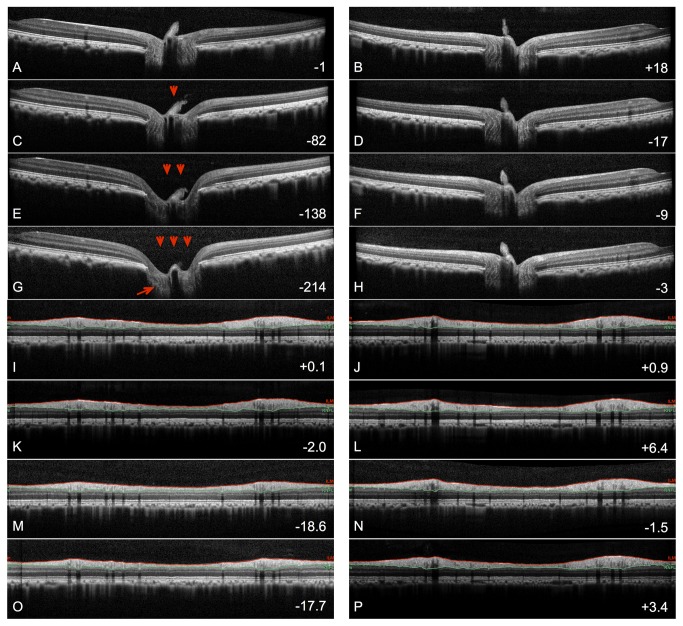
Longitudinal series of SDOCT B-scans crossing through the optic nerve head and fovea in the EG eye (A,C,E,G) and fellow control eye (B,D,F,H) of the same animal shown in Figure 1.The four time points shown are: baseline 3 (A,B), MPD endpoint (C,D), RNFL thickness endpoint (E,F) and the final available time point (G,H). (I-P) SDOCT peripapillary circular B-scans obtained at the same set of four time points. The numbers in the lower right corner of each panel represent the change from baseline average (in µm) for MPD (panels A-H) and RNFL thickness (panels I-P). Signficant posterior deformation of the ONH surface occurred in the EG eye (red arrowheads) prior to significant change in RNFL thickness. Posterior deformation of the lamina cribrosa was evident in the scans through the ONH (red arrow).